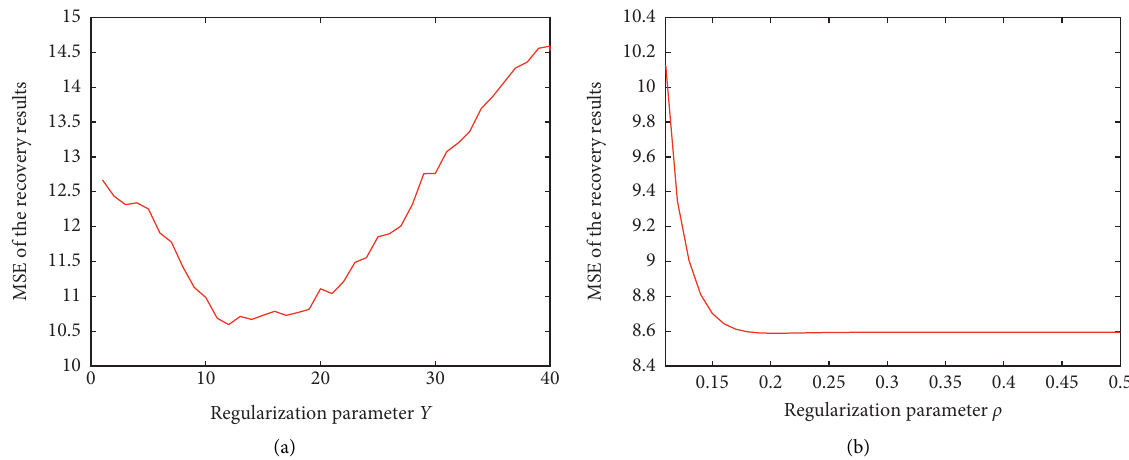
Figure 7: Effect of the regularization parameter c and penalty parameter ρ on the MSE of the recovery results. (a) Convergent curve ( ρ � 0 . 2). (b) Convergent curve ( c �